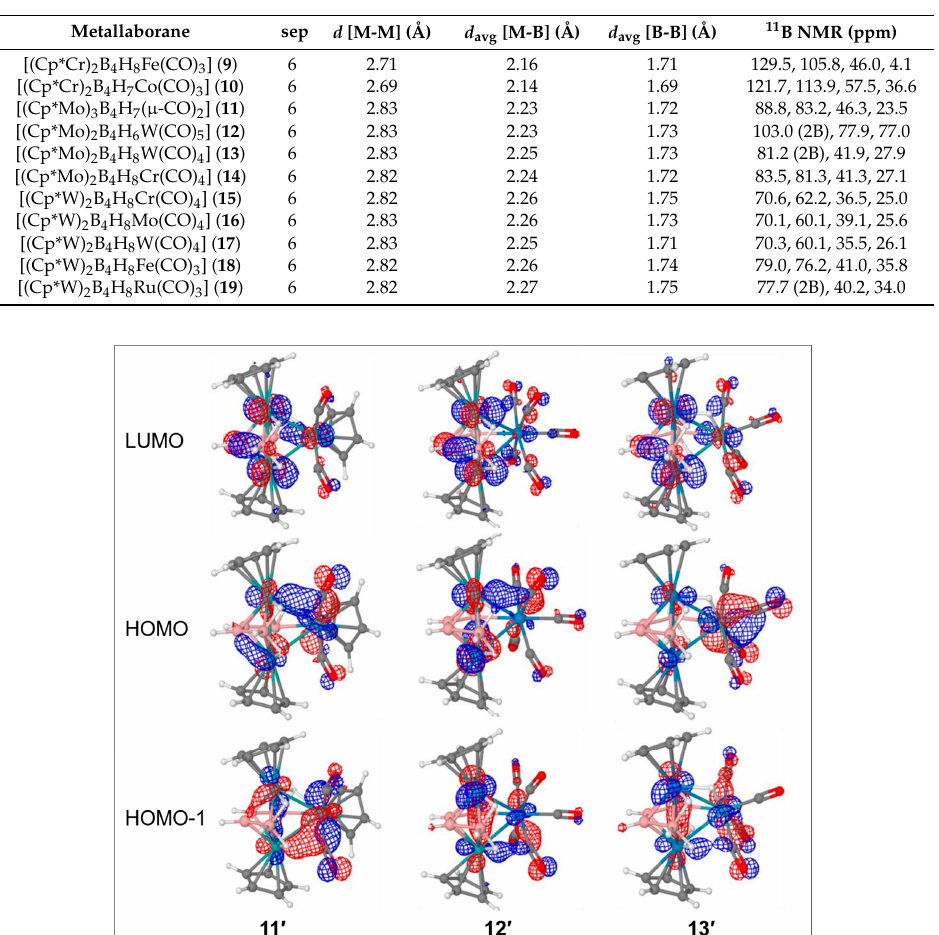
Table 2. Skeletal electron pair (sep) count, selected structural parameters and 11 B chemical shifts of 9 – 19 .